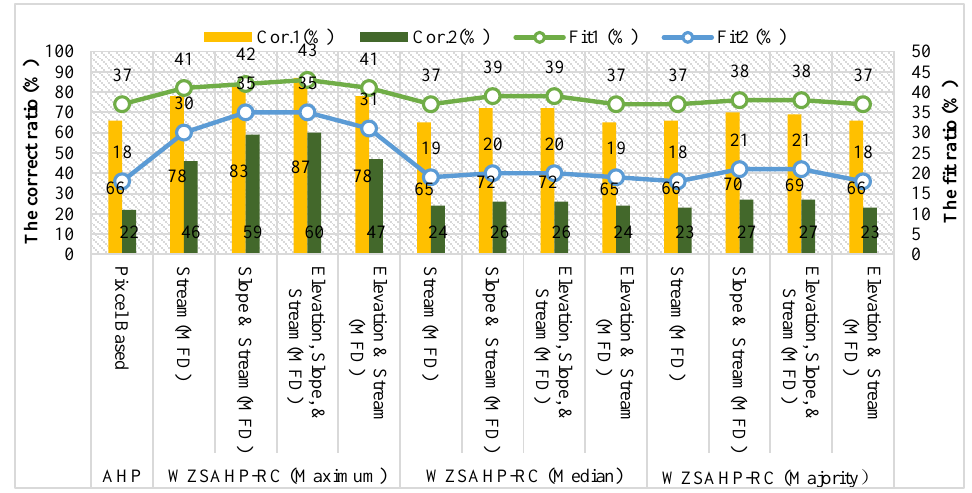
Figure 8. The correct ratio and fit ratio values of pixel-based AHP and sub-watershed-based WZSAHP-RC models constrain different kinds of converging related indicators.